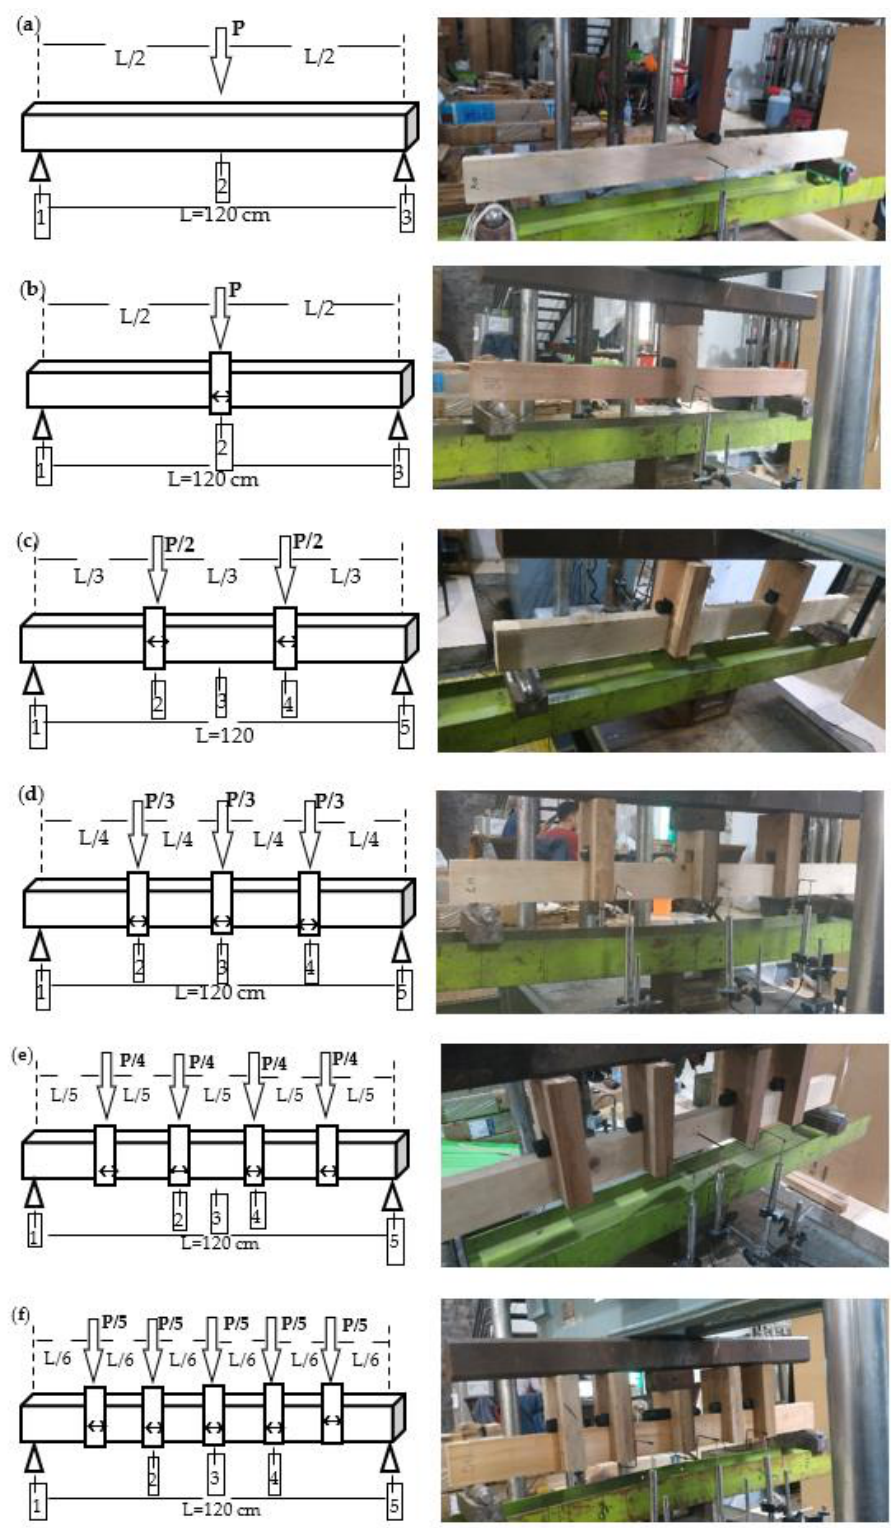
Figure 3. Scheme of a single-span beam subjected to concentrated loads at several points: ( a ) center- point loading without lateral support, ( b ) center-point loading, ( c ) third point loading, ( d ) fourth point loading, ( e ) fifth point loading, ( f ) sixth point loading (Note: P = applied load; L = span; ↔ = lateral support; =